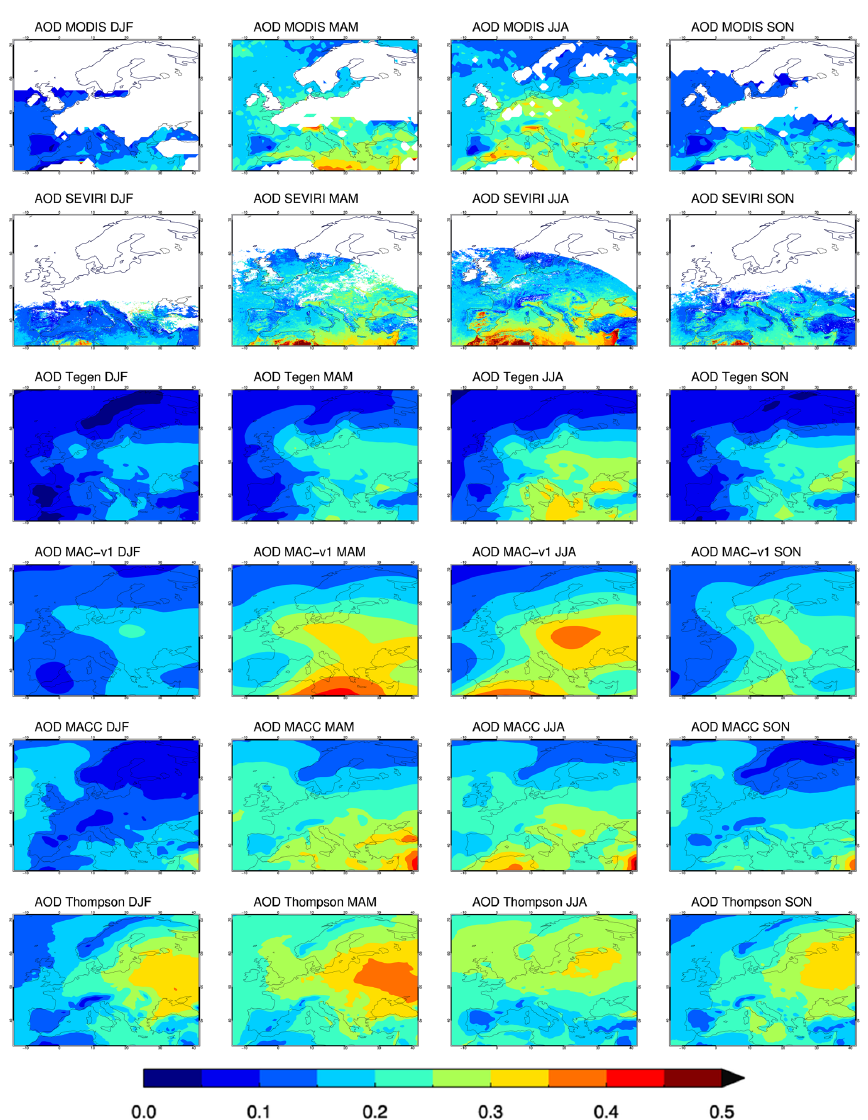
Figure 1. Mean seasonal aerosol optical depth at 550nm for (from top to bottom) the MODIS TERRA satellite dataset, the CM SAF SEVIRI satellite dataset, the Tegen climatology, the MAC-v1 climatology, the MACC reanalysis and the ARCI simulation produced by the Thompson aerosol–cloud interacting